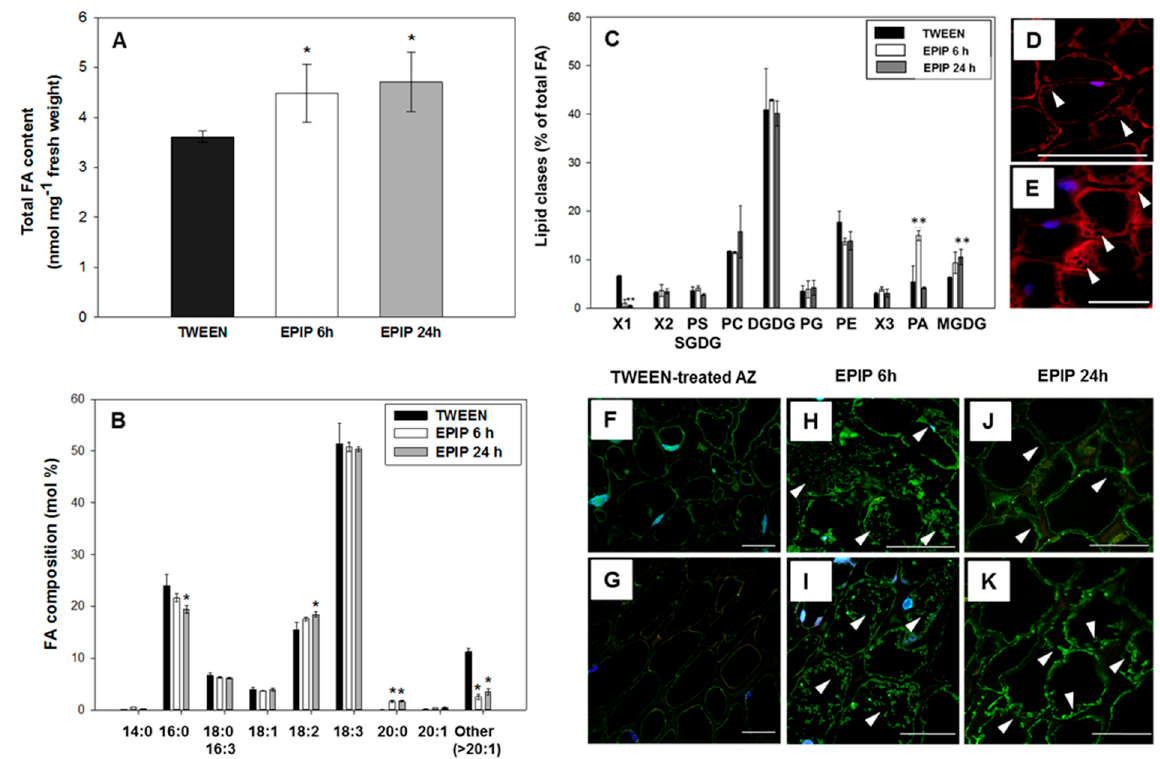
Figure 6. EPIP strongly influences lipid homeostasis in the floral abscission zone (AZ) of yellow lupine. Total fatty acid (FA) content ( A ) and composition ( B ), composition of all acyl-lipids ( C ), neutral lipids presence ( D , E ), and phospholipase D (PLD) localization ( F – K ). The fragments of AZ were excised on the 6 h and 24 h after application of EPIP (100 µM) solution in 0.05% Tween 20 directly to inactive AZ. Inactive AZ was dissected from the flower bases after the application of the 0.05% Tween 20 solution only. Error bars on the charts indicate SE. For total FA content in acyl-lipids, significant differences for EPIP-treated plants in comparison to Tween-treated are indicated as * p < 0.05 ( A ). For FA composition, significant differences for EPIP treated plants in comparison to control are indicated as * p < 0.05 ( B ). For lipid classes significant differences for EPIP treated plants in comparison to Tween-treated are indicated as ** p < 0.01 ( C ). Abbreviations: PS—phosphatidylserine, SQDG—sulfoquinovosyl-diacylglycerol, PC—phospholipids phosphatidyl-choline, DGDG—digalactosyl-diacylglycerol, PG—phosphatidylglycerol, PE—phosphatidyl-ethanolamine, PA—phosphatidic acid, MGDG—monogalactosyl-diacylglycerol, X1, X2, and X3—unidentified lipids localized on the TLC plate. The localization of neutral lipids (red fluorescence marked by arrows) was analyzed using Nile Red staining of sections dissected 6 h after EPIP treatment ( D , E ). PLD was localized 6 h ( H , I ) and 24 h ( J , K ) after EPIP application, as well as in Tween-treated AZ ( F , G ). Photos G, I, and K are magnifications of F, H, and J, respectively. The green fluorescence marked by arrows corresponds to PLD presence. Nuclei were stained with DAPI (blue fluorescence). Bars—50 µm ( D , E ), 60 µm ( F – K ).